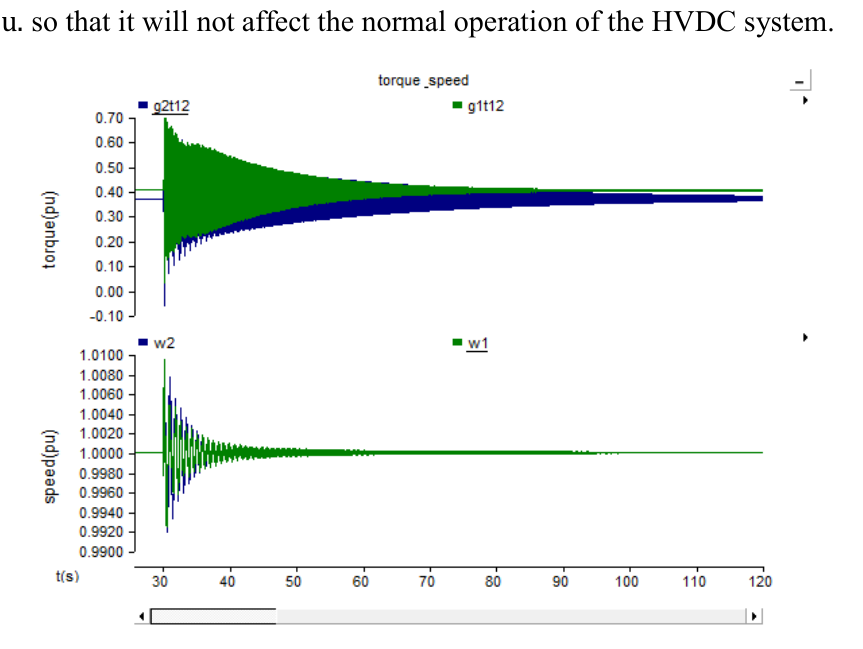
Figure 11. Torques and speeds of generators when SSDC is